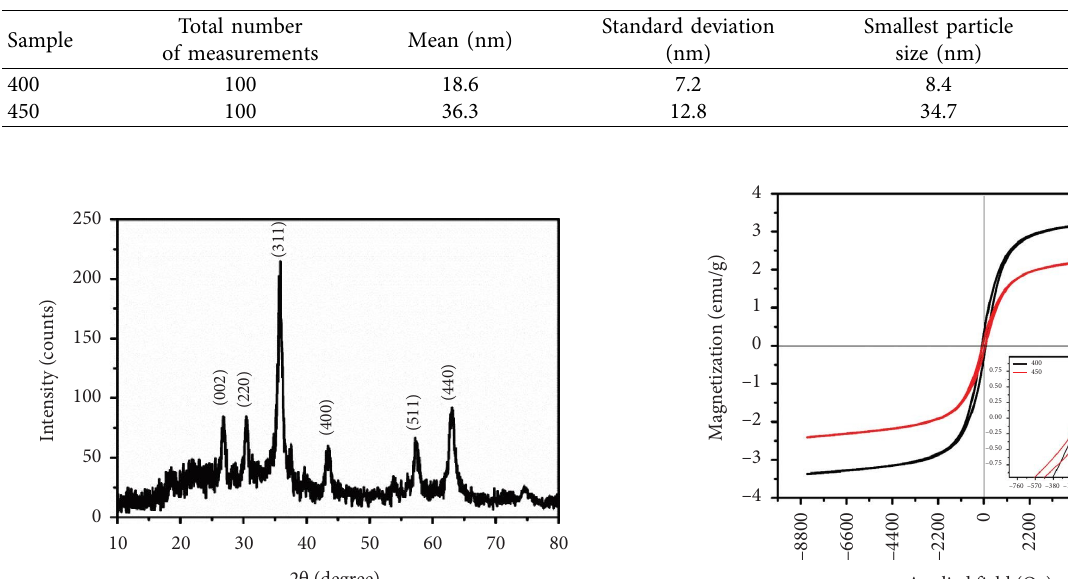
Figure 2: Histograms of particle size distribution in micrographs of tea waste magnetic nanoparticles at (a) 400 and (b) 450 ° C. Table 1: Statistical results of histograms of magnetite nanoparticles.